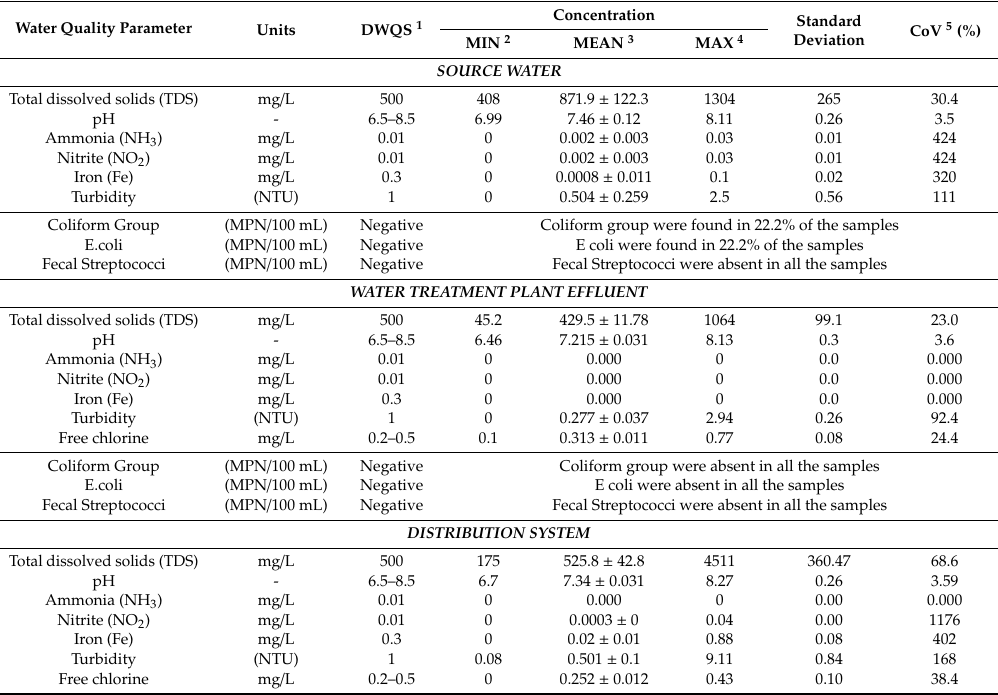
Negative Coliform group were absent in all the samples